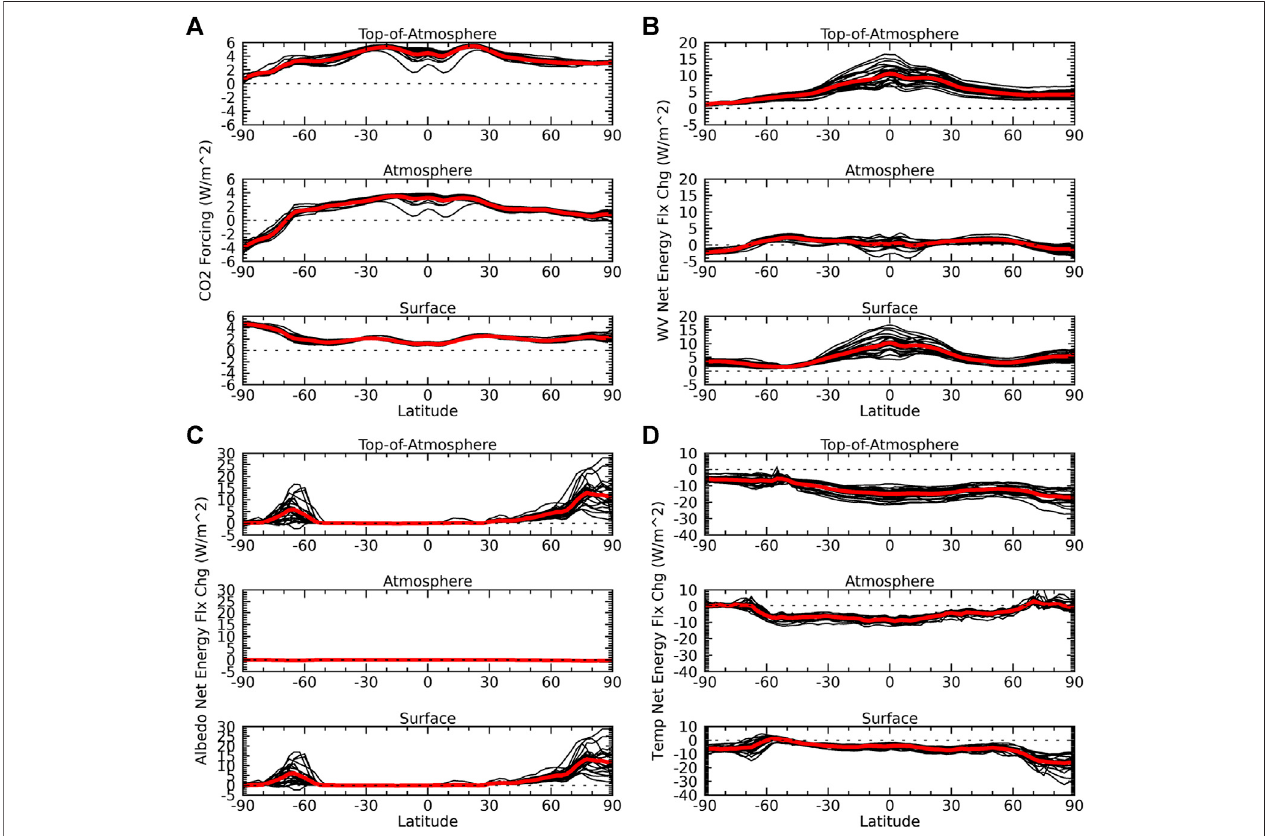
FIGURE 2 | The zonal-mean net energy fl ux change (W*m − 2 ) at the TOA, atmosphere, and surface due exclusively to changes in (A) CO 2 , (B) water vapor, (C) surface albedo, (D) and temperature. The sum of the surface and atmosphere contributions equals their respective TOA contributions. Individual CMIP5 models (black lines); CMIP5 ensemble mean (red